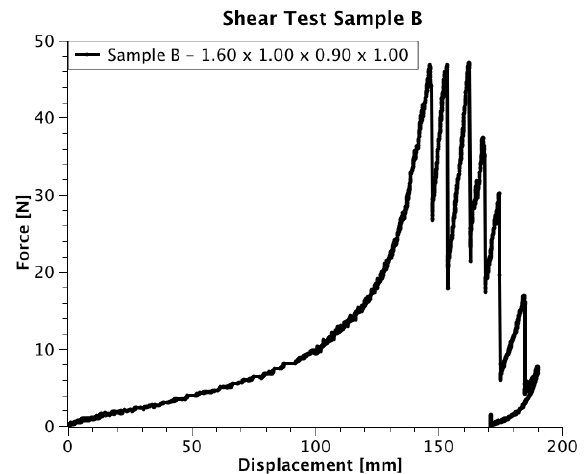
Figure 8. Raw-data of sample B; force F is plotted over displacement x